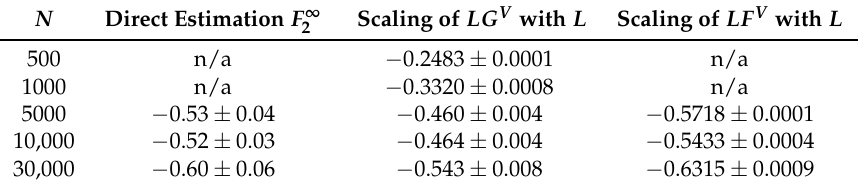
Table 6. Surface term in the thermodynamic limit F ∞ for a LJ system at T = 2 and ρ = 0.4 (dimensionless units). Values of F ∞ are computed from systems with various number of particles N and using the different methods listed in Table